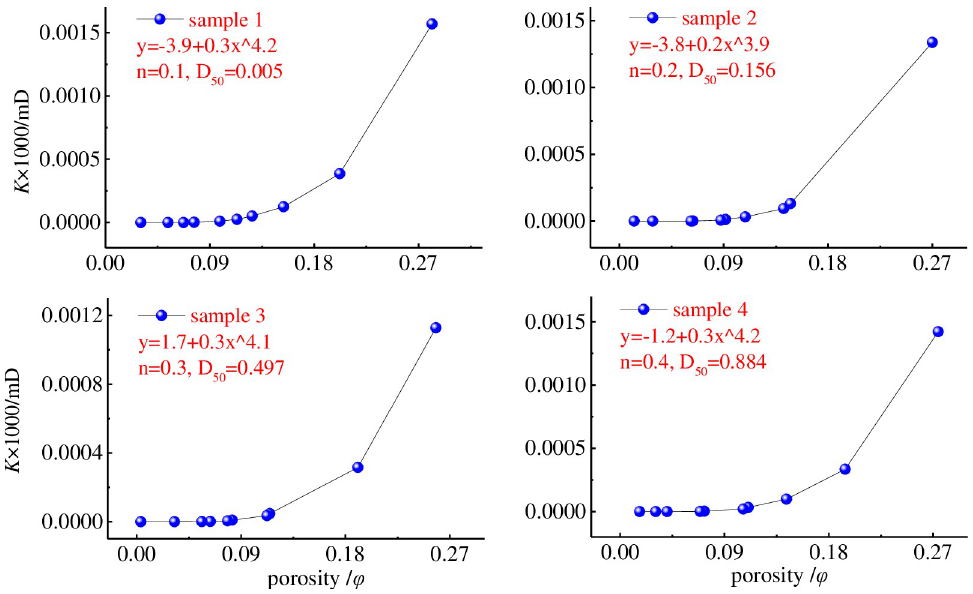
Fig 7. Relationship between effective stress and permeability of samples.